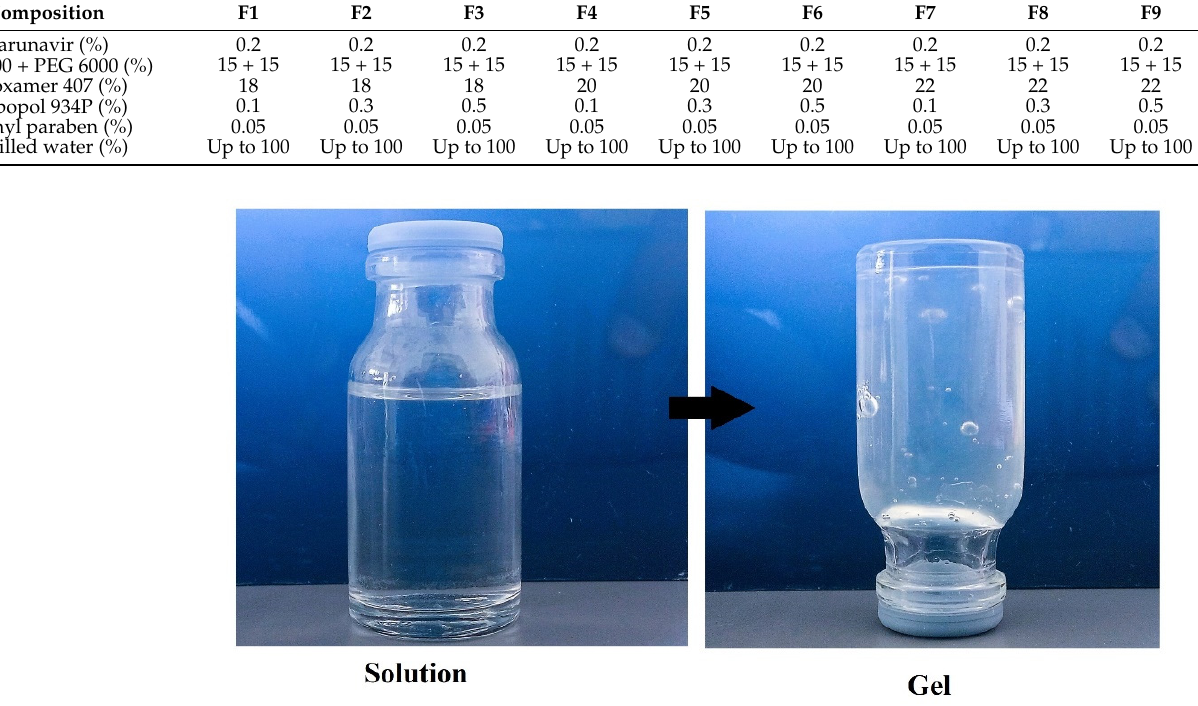
Figure 3. Representative photographs of nasal in situ formulation in solution and gel state.